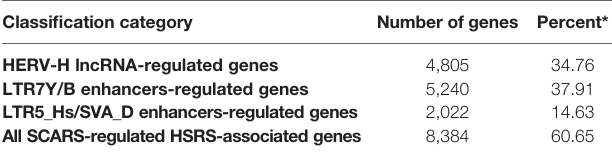
TABLE 2 | SCARS regulate expression of a majority of 13,824 genes associated with human-speci fi c regulatory sequences (HSRS).